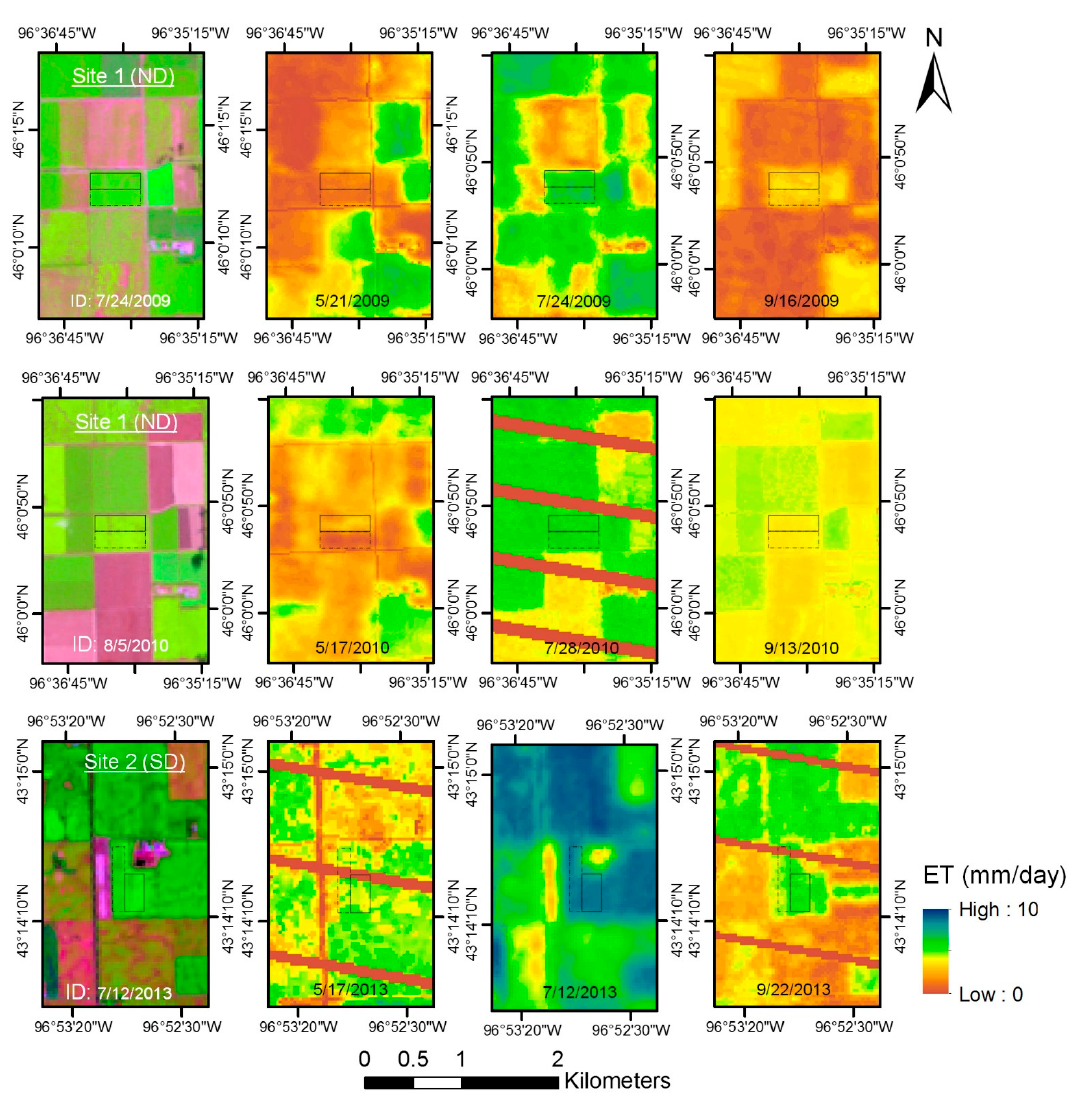
Figure 4. Daily ET from the subsurface drained (solid rectangle) and undrained (dashed rectangle) fields for the selected Landsat image dates of May (second column), July (third column), and September (last column). The first column represents Landsat false color image (RGB: 5,4,3). ET data gaps associated with Landsat 7 images were filled by the natural neighbor interpolation